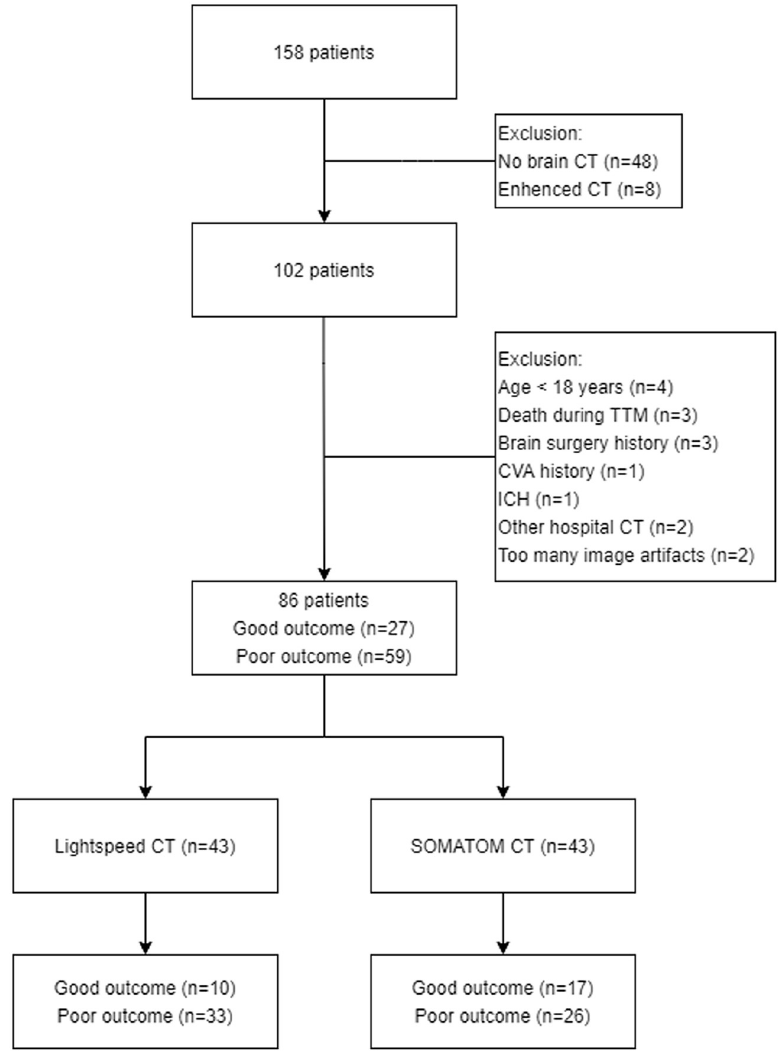
Fig 1. Flow diagram of the study population. CT, computer tomography; TTM, target temperature management; CVA, cerebrovascular accident; ICH, intracranial hemorrhage; CT 1, LightSpeed VCT; CT 2, SOMATOM definition